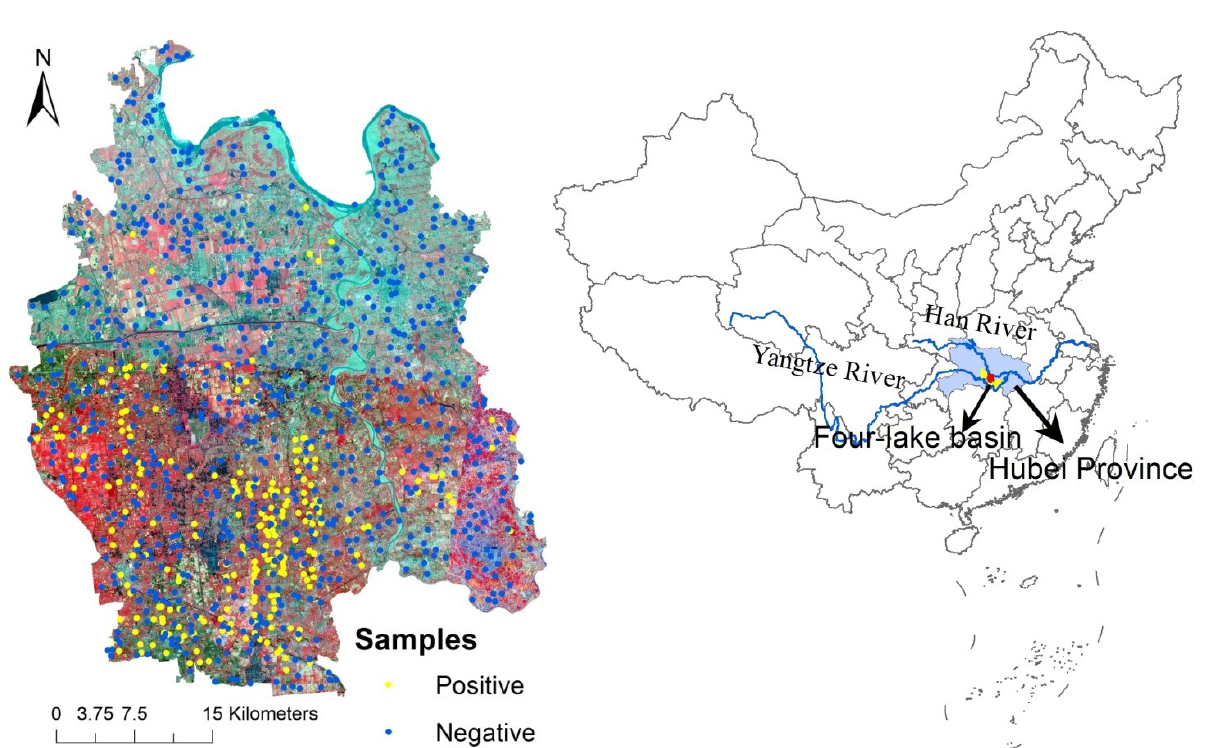
Figure 1. Qianjiang City location and sample distribution. Fusion and mosaic remote sensing images are